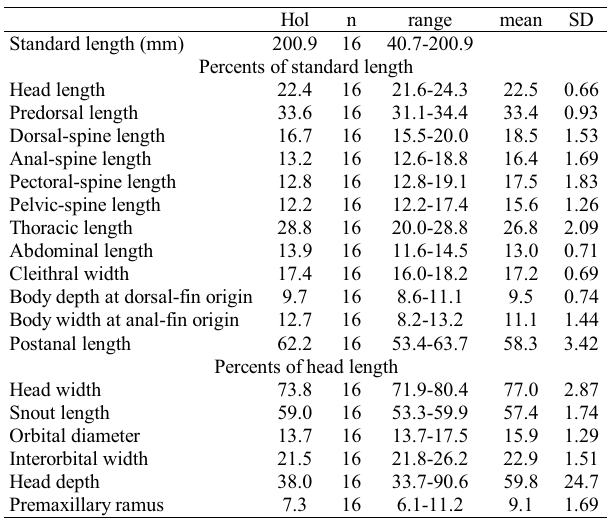
Table 1. Morphometric characters for holotype and paratypes of Rineloricaria daraha